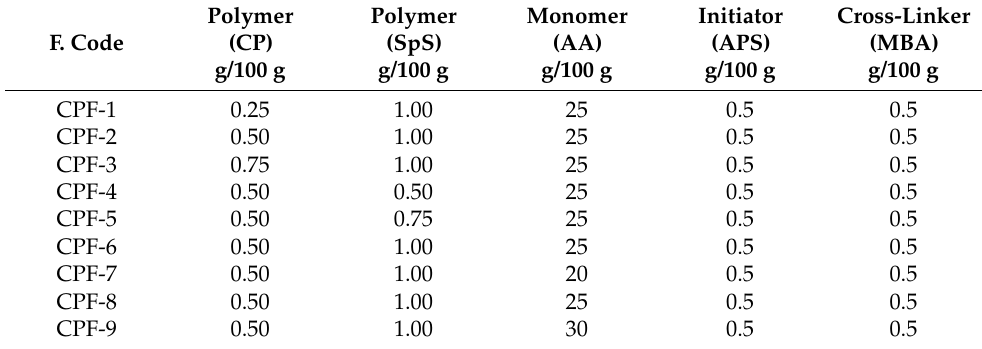
Table 4. Feed ratio scheme for formulation of CP/SpScPAA hydrogels.